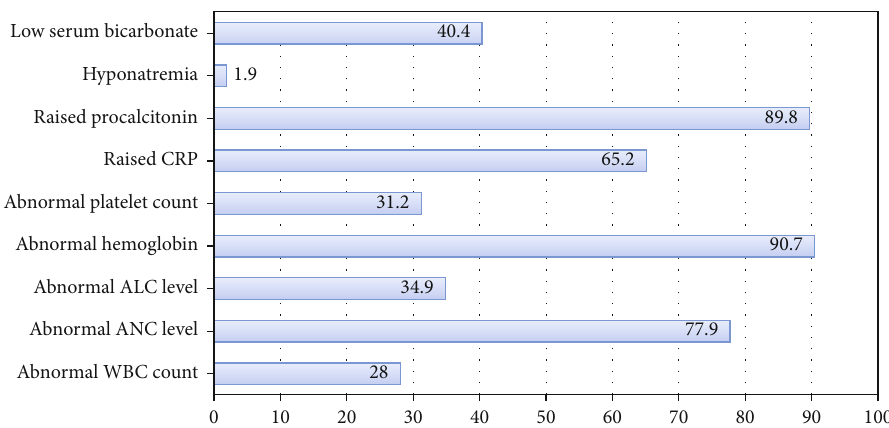
Figure 1: Laboratory investigation results in pediatric patients studied ( n = 405